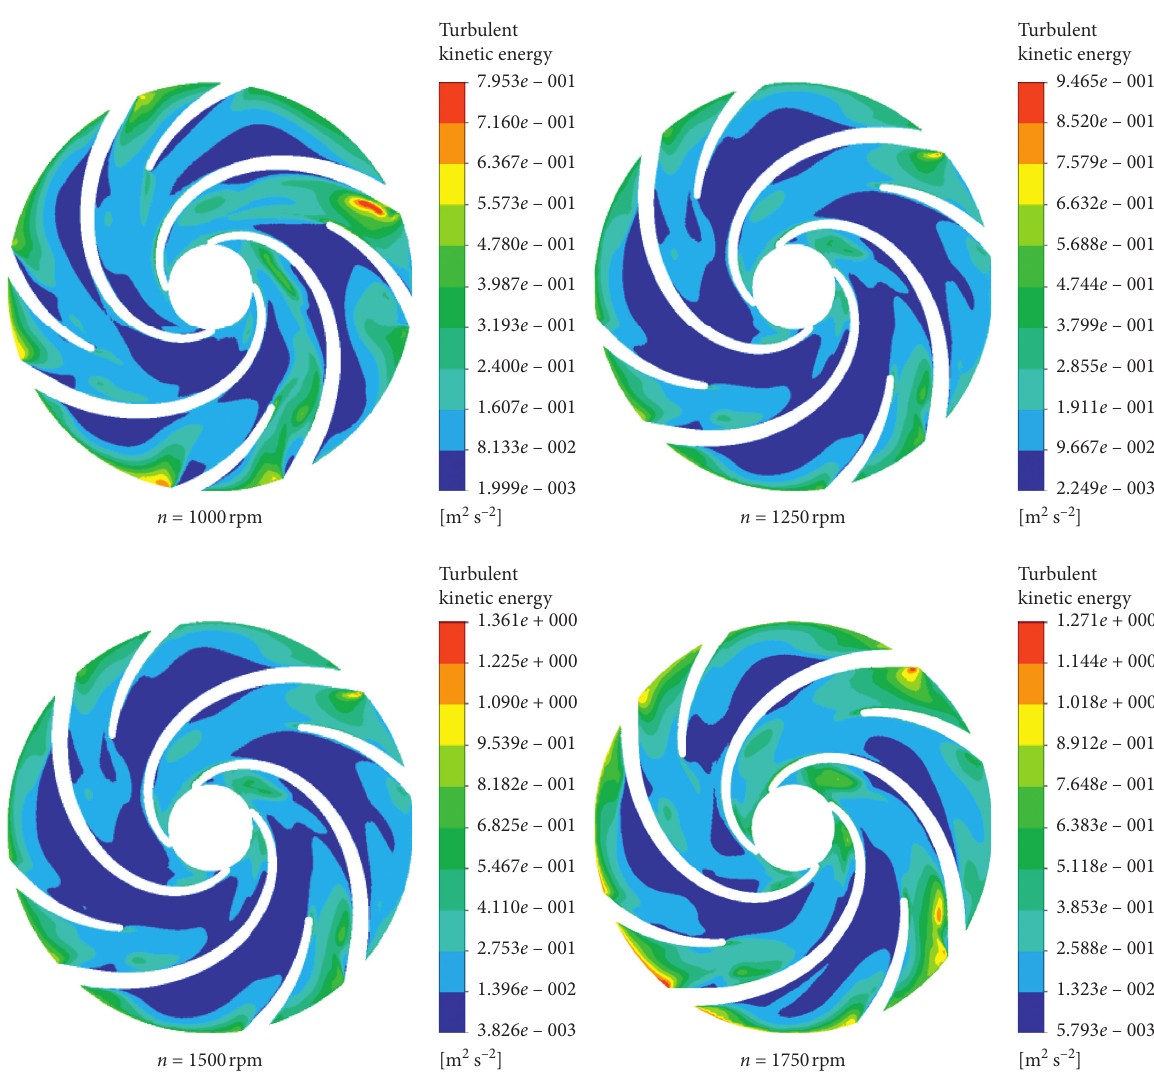
Figure 8: Turbulence dissemination for the Pump as Turbine diverse speed at BEP